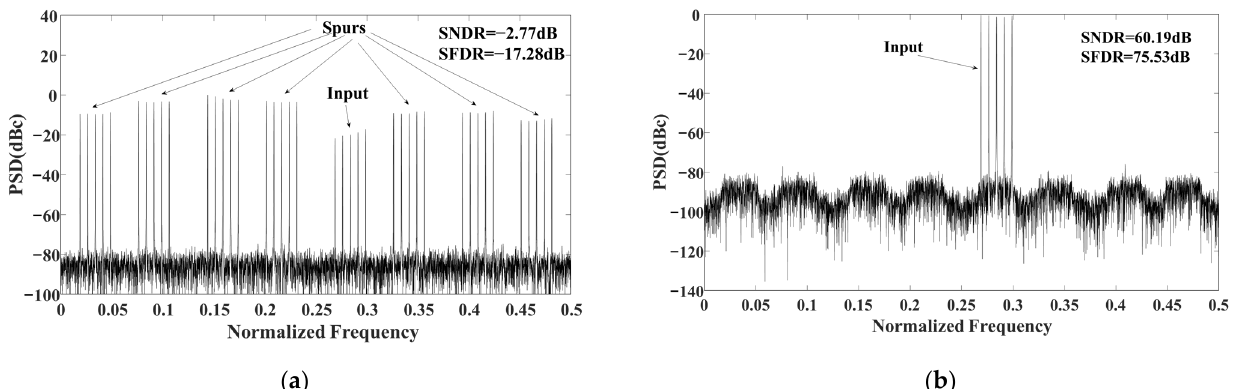
Figure 10. Performances of mismatches calibration for a multi-tone signal. ( a ) Before calibration; ( b ) after calibration.